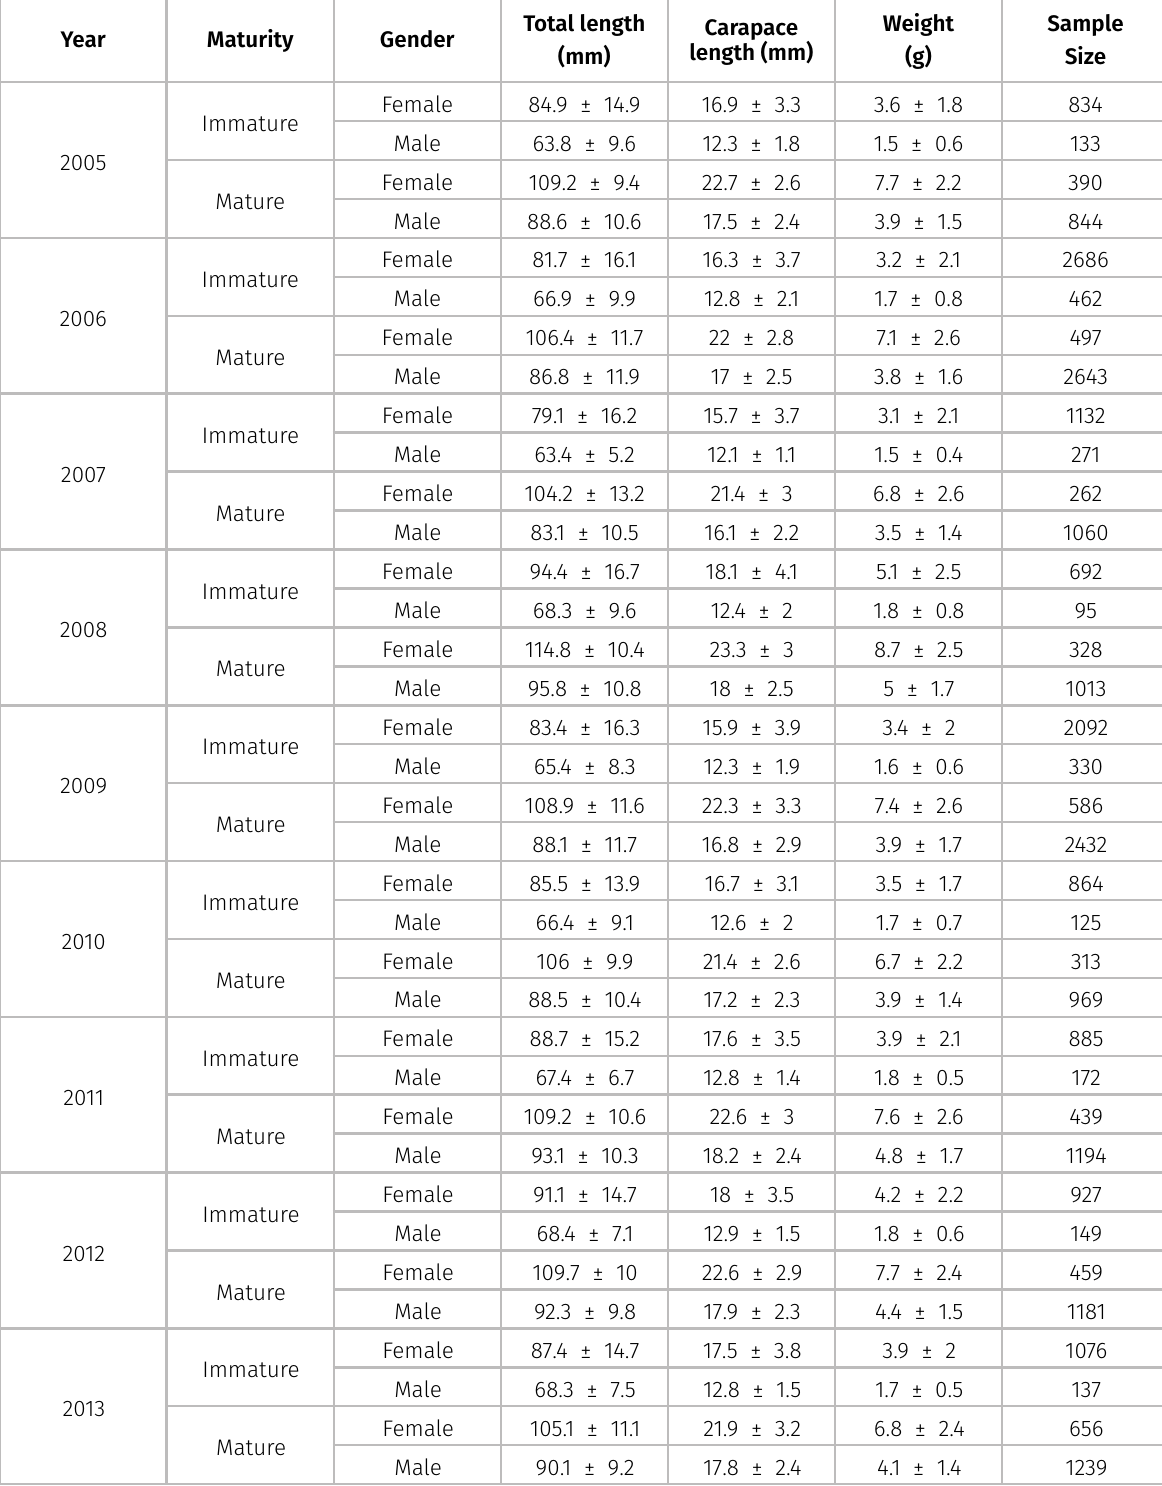
Table II. Body dimensions and sample size of Xiphopenaeus kroyeri from northern Rio de Janeiro State, southeast Brazil for each year, maturity stage and gender. Values are mean ± standard